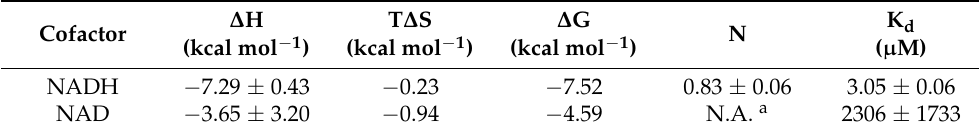
Figure 3. Comparison of L -malate-NAD bound form ( A ) with oxaloacetate-NADH bound form ( B ). Substrates are shown as sticks, and interacting residues are shown as lines ( L -malate binding in lime; oxaloacetate binding in cyan). ( C ) Cartoon diagram of hMDH2 complexed with substrates and cofactors. The active site is enlarged. Substrates and cofactors are shown as sticks, and His200 residue is represented as a line (colors are the same as in ( A , B )). Table 2. Data collection and refinement statistics at 298.15